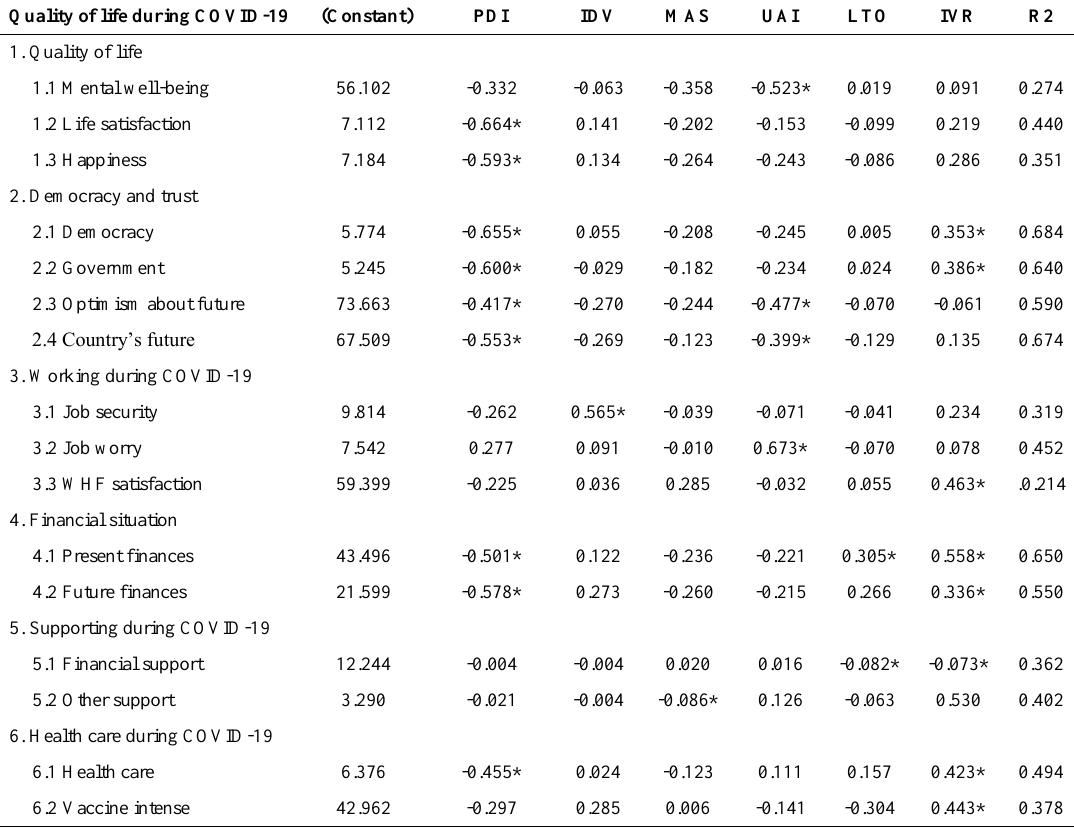
Table 2. Culture dimensions that affect the quality of life of Europeans during the COVID-19 pandemic Quality of life during